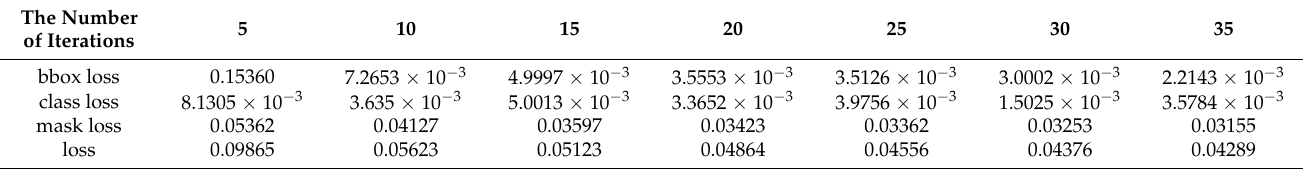
Table 2. Detailed loss function data of Mask R-CNN at different iteration levels.